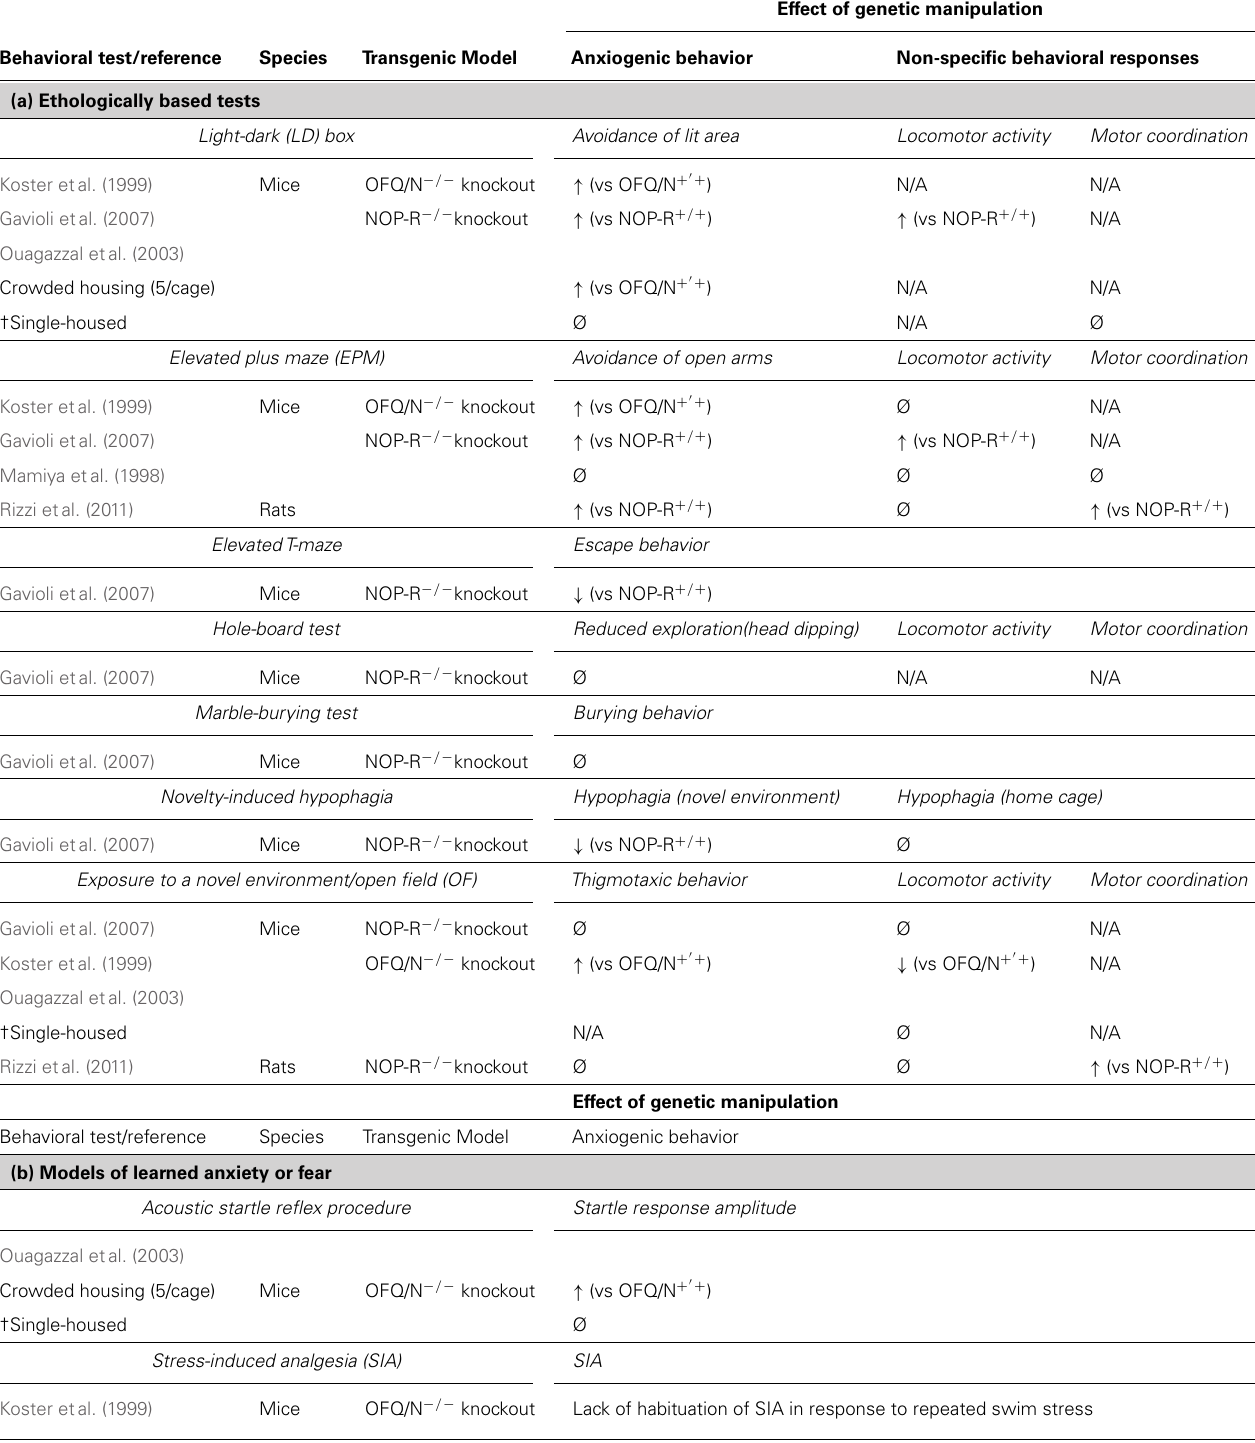
Table 4 | Effects of targeted deletion of endogenous OFQ/N and NOP-R signaling on the expression of (a) innate and (b) learned anxiety-like or fear-like behavior in